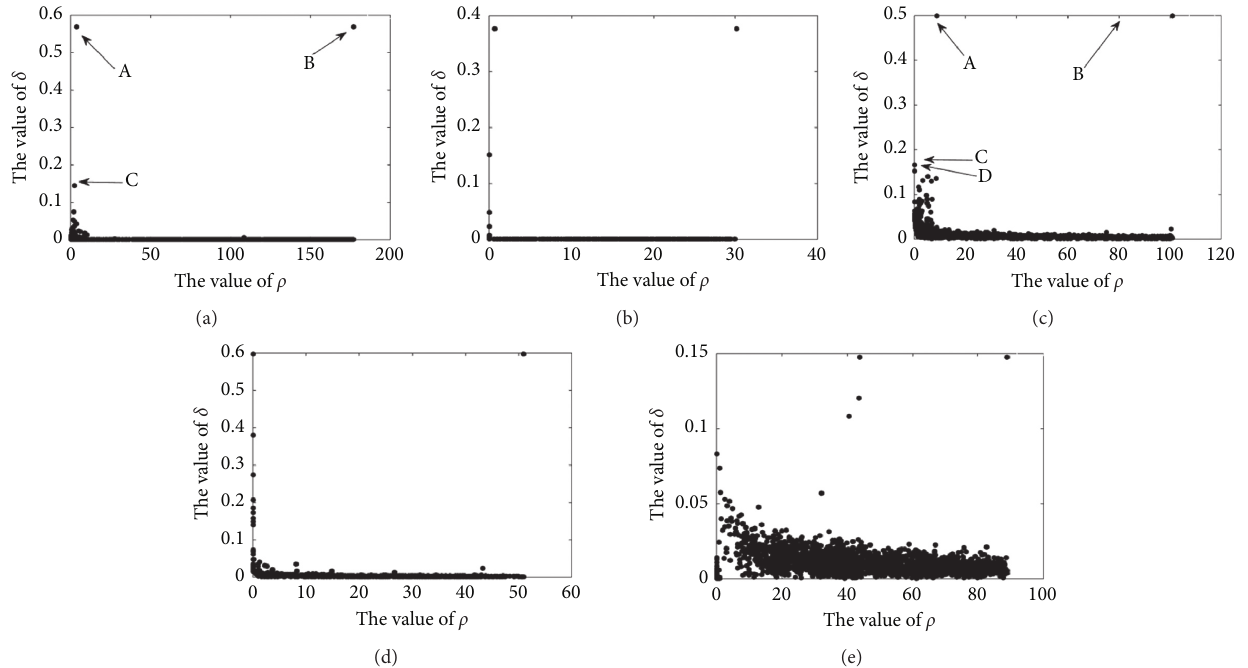
Figure 14: Result of local density ρ i and the distance δ i by using the SAE-CFS for bearings 11–15. (a) SAE-CFS-bearing 11. (b) SAE-CFS- bearing 12. (c) SAE-CFS-bearing 13. (d) SAE-CFS-bearing 14. (e) SAE-CFS-bearing